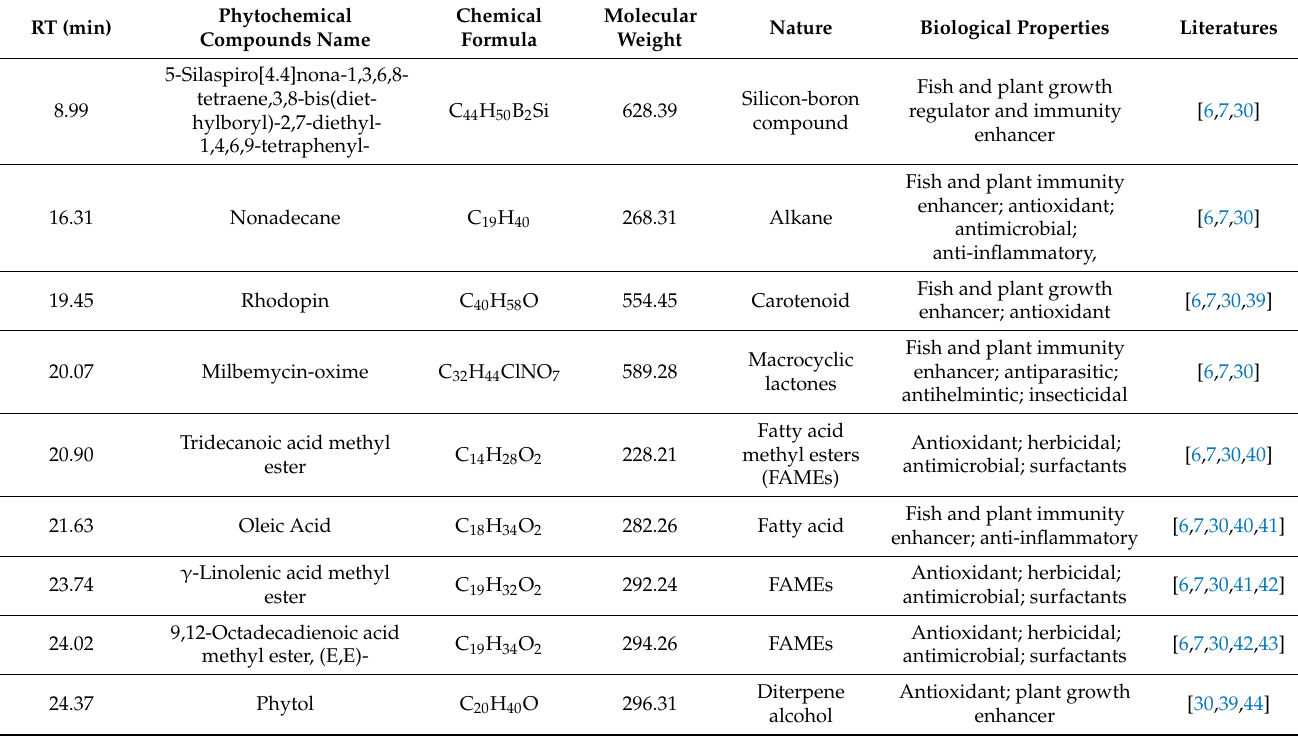
Table 1. Phytochemical constituents of seaweed biostimulant, TAM ® , with the most important biological activities according to literature